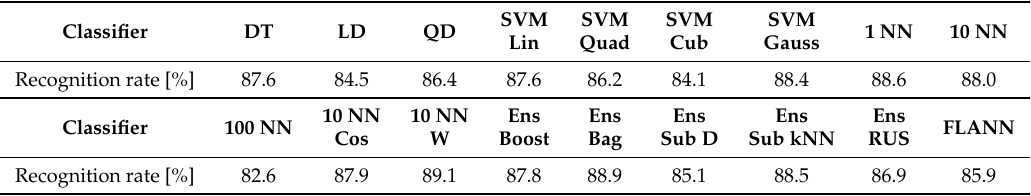
Table 7. 10-fold cross-validation results for dataset 2.